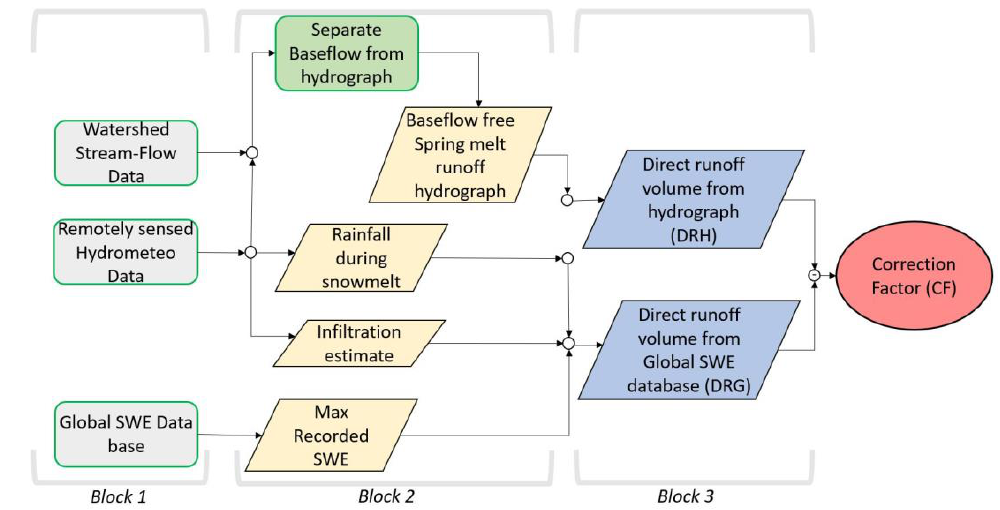
Figure 1. Overall methodology of the WSC approach developed for computing CF.